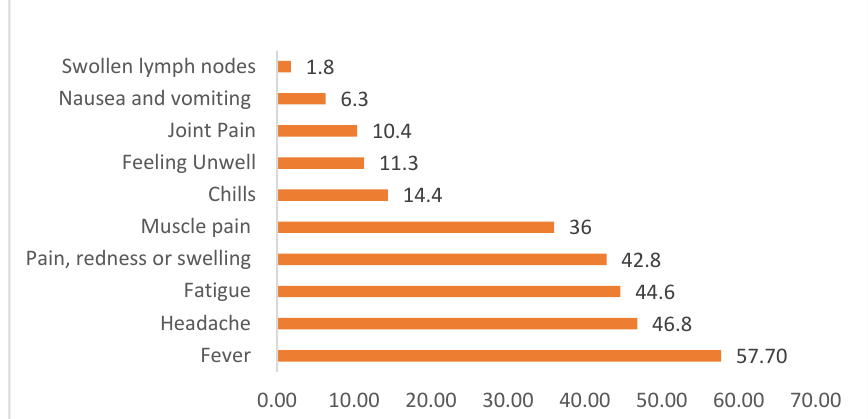
Figure 2. Self-reported COVID-19 vaccination adverse effects among vaccinated individuals at the time of the COVID-19 vaccine hesitancy survey, Ethiopia, 2022.